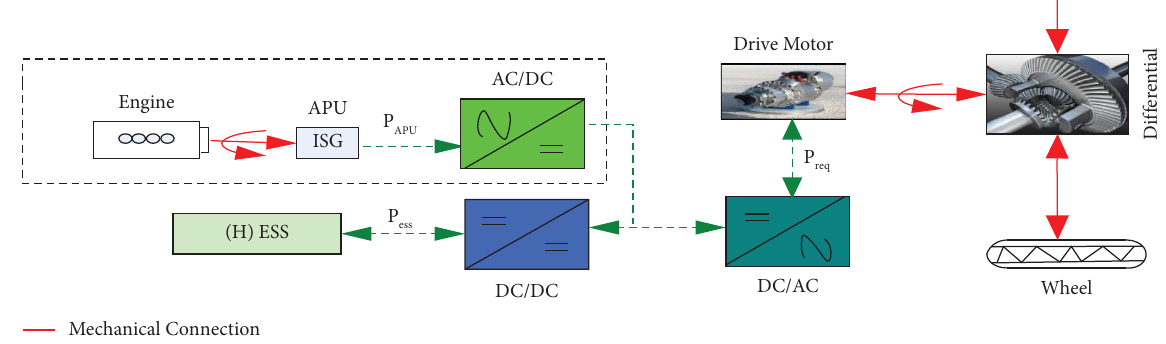
Figure 10: Overview of engine based EREV power fow.